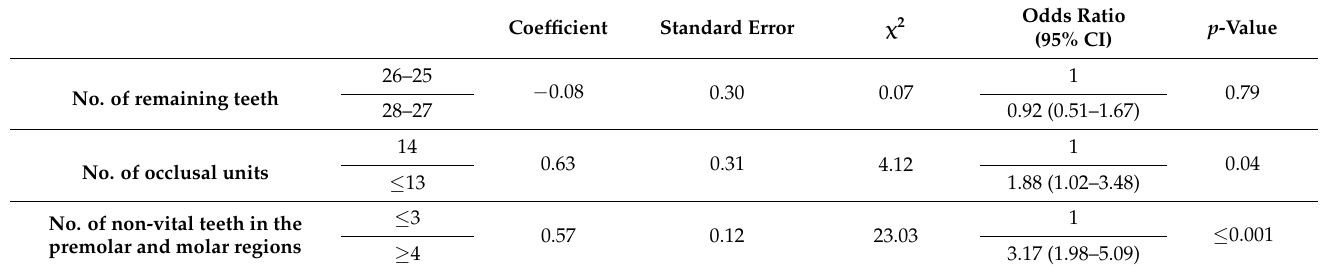
Table 7. Multiple logistic regression analyses of study variables with tooth